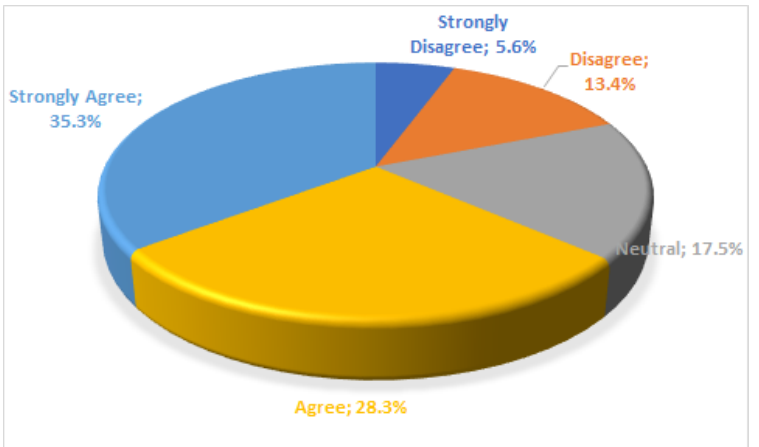
Figure 11. Answers to a Likert five-point scale to the question: Do you think the tests employed have helped in the development and reinforcement of the knowledge that was being